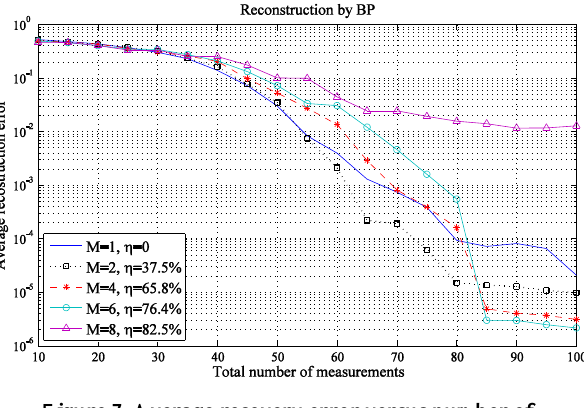
Figure 7. Average recovery error versus number of measurements. 𝑴 denotes the number of segments and 𝜼 indicates the percentage of zero components in 𝚽